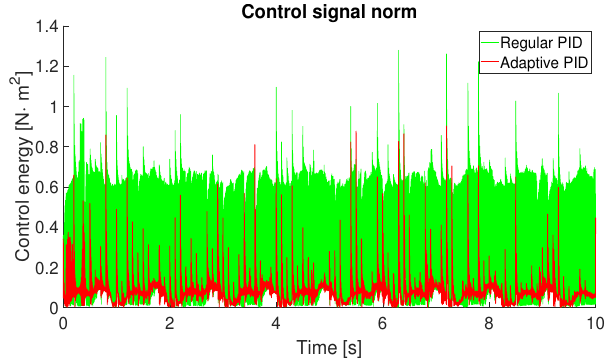
Figure 6. Control signals